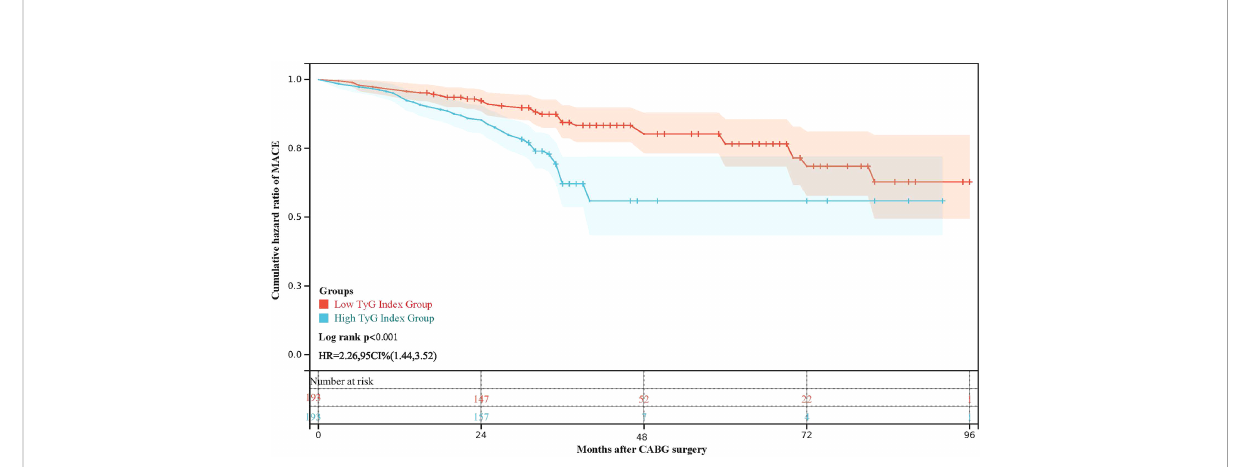
FIGURE 2 Kaplan-Meier survival curve for freedom from MACE in high TyG index group and low TyG index